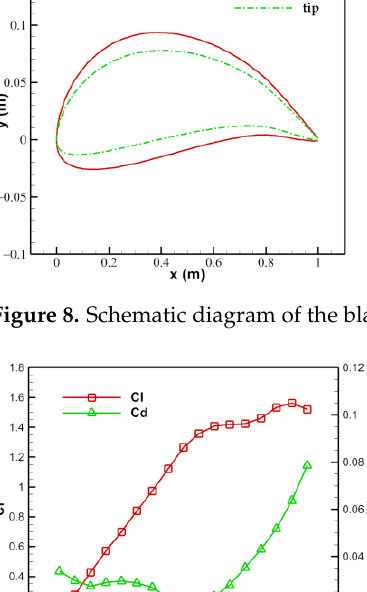
Table 3. Performance comparison of the 150 ducted fan.